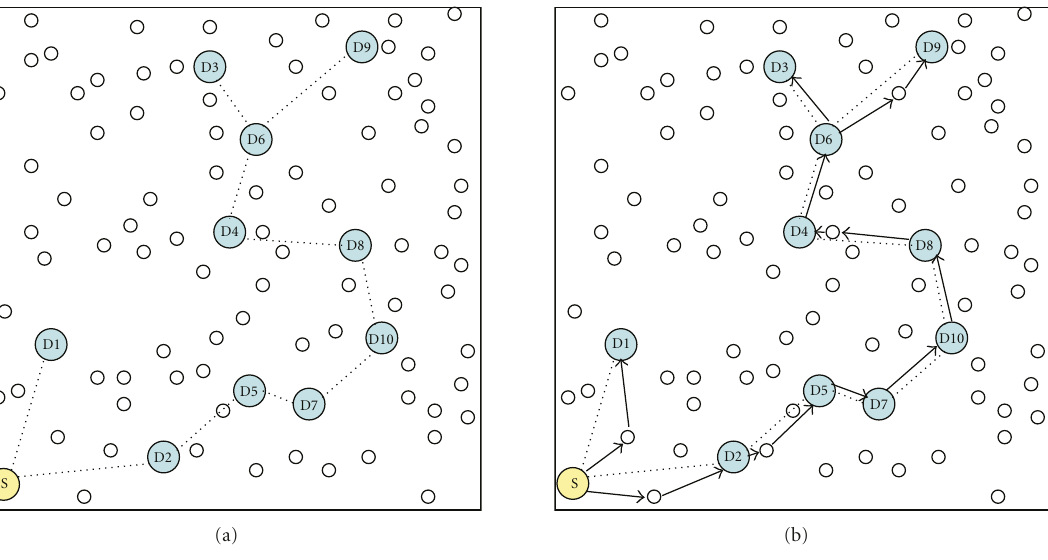
Figure 5: A sample run of LBM-MST with 10 destinations.